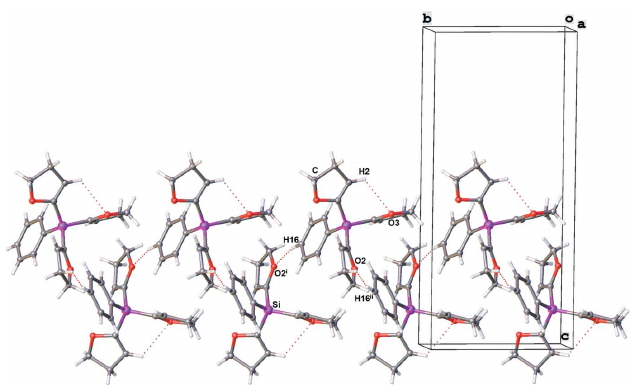
Figure 7 The crystal packing of compound 2 in a partial view along the a axis, showing intermolecular and intramolecular hydrogen bonds C16— H16 (cid:2)(cid:2)(cid:2) O2 i and C2—H2 (cid:2)(cid:2)(cid:2) O3. [Symmetry codes: (i) (cid:5) x + 1, y + 1 (cid:5) z + 3 ; (ii) (cid:5) x + 1, y (cid:5) 1 , (cid:5) z + 3 2 2 2